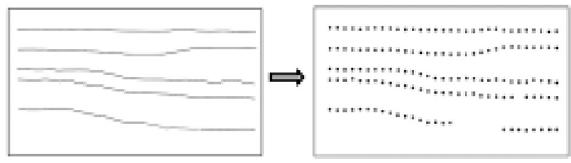
Figure 12. Schematic diagram of section information extraction.